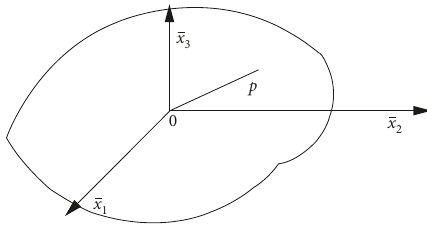
Figure 2: The curved surface of limit state.